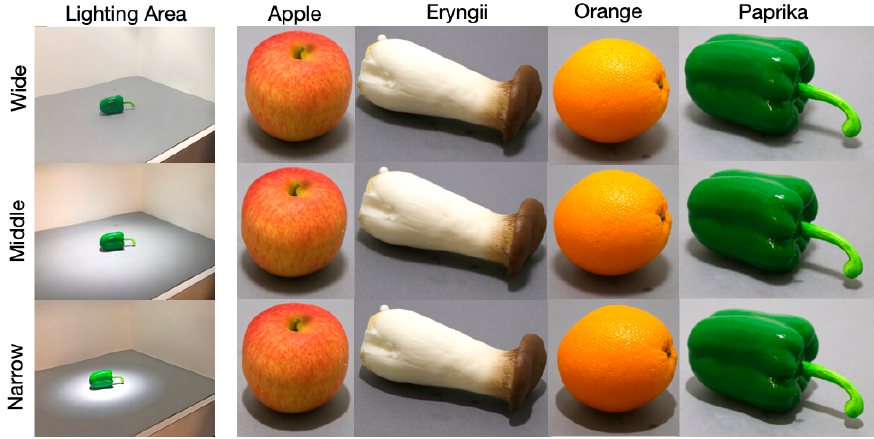
Figure 2 . Spotlight size and the appearance of each stimulus. Wide size spotlight has high diffuseness, Middle size has moderate diffuseness, and Narrow size has low diffuseness.